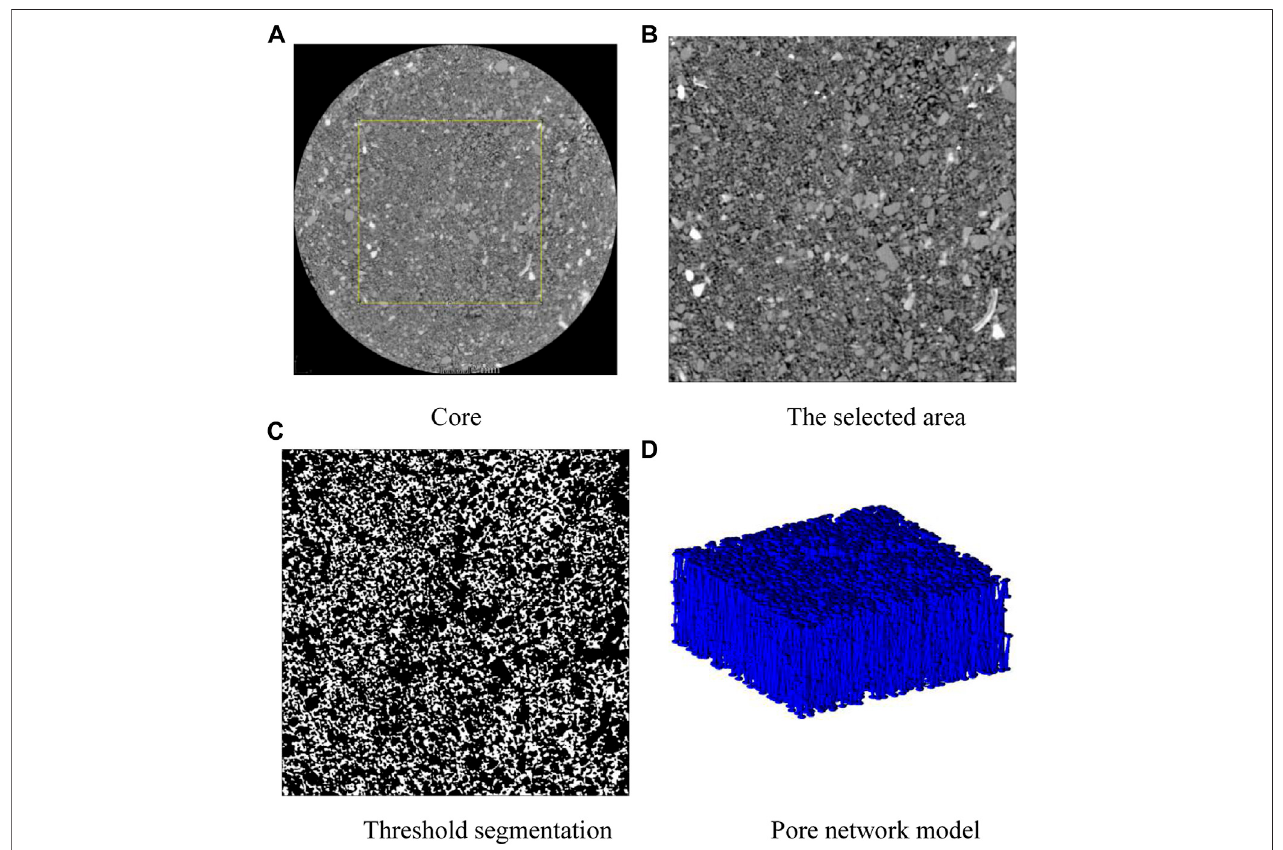
FIGURE 2 | Formation process of the pore network model. (A) Core, (B) selected area, (C) threshold segmentation, and (D) pore network model.